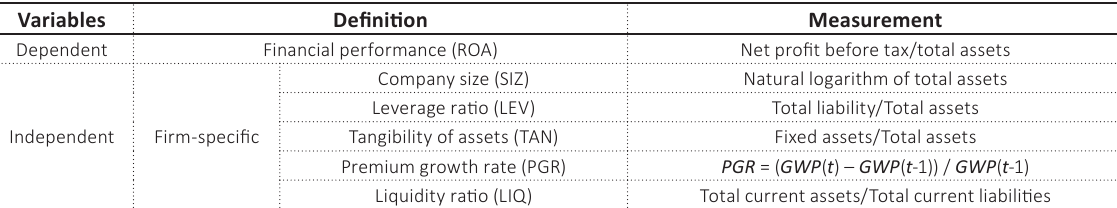
Table 1. Variables’